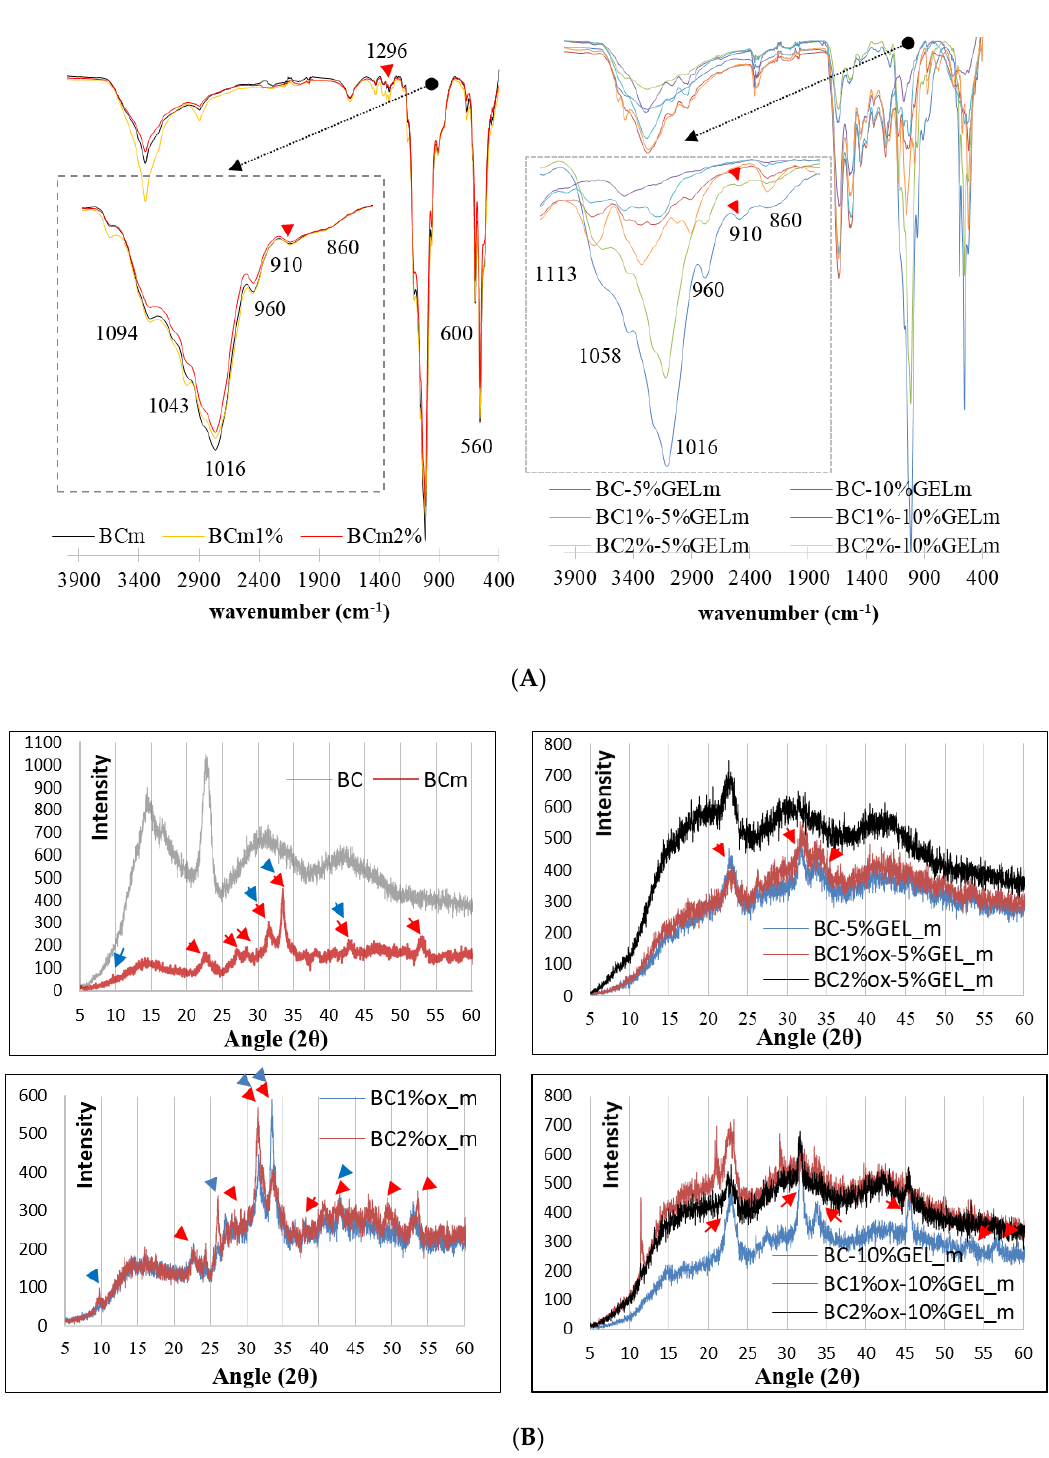
Figure 5. ( A ) FTIR and ( B ) X-Ray Diffraction (XRD) patterns of selected BC–GEL membranes with different periodate and GEL concentrations, after a 6-h incubation process in 10× SBF media at room temperature. Red and blue triangles are assigned to the HAp and OCP phases, respectively. The subscript m stands for mineralized samples.